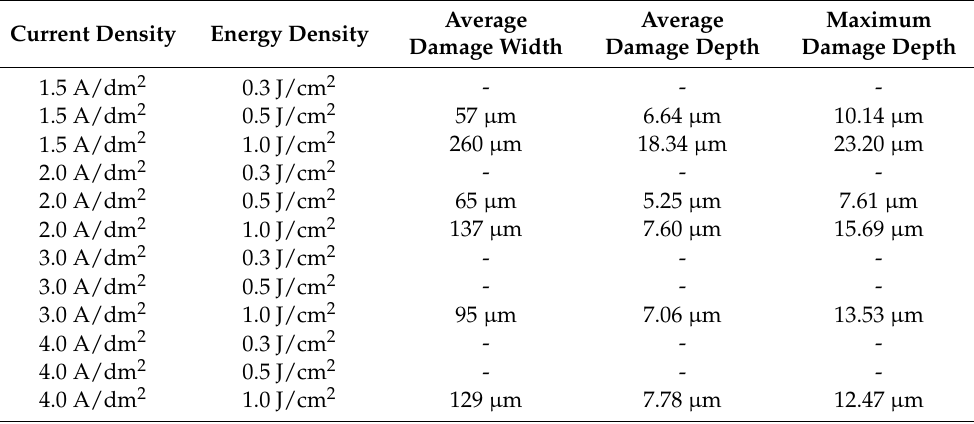
Table 8. Width and depth of laser damage pit of current density group.